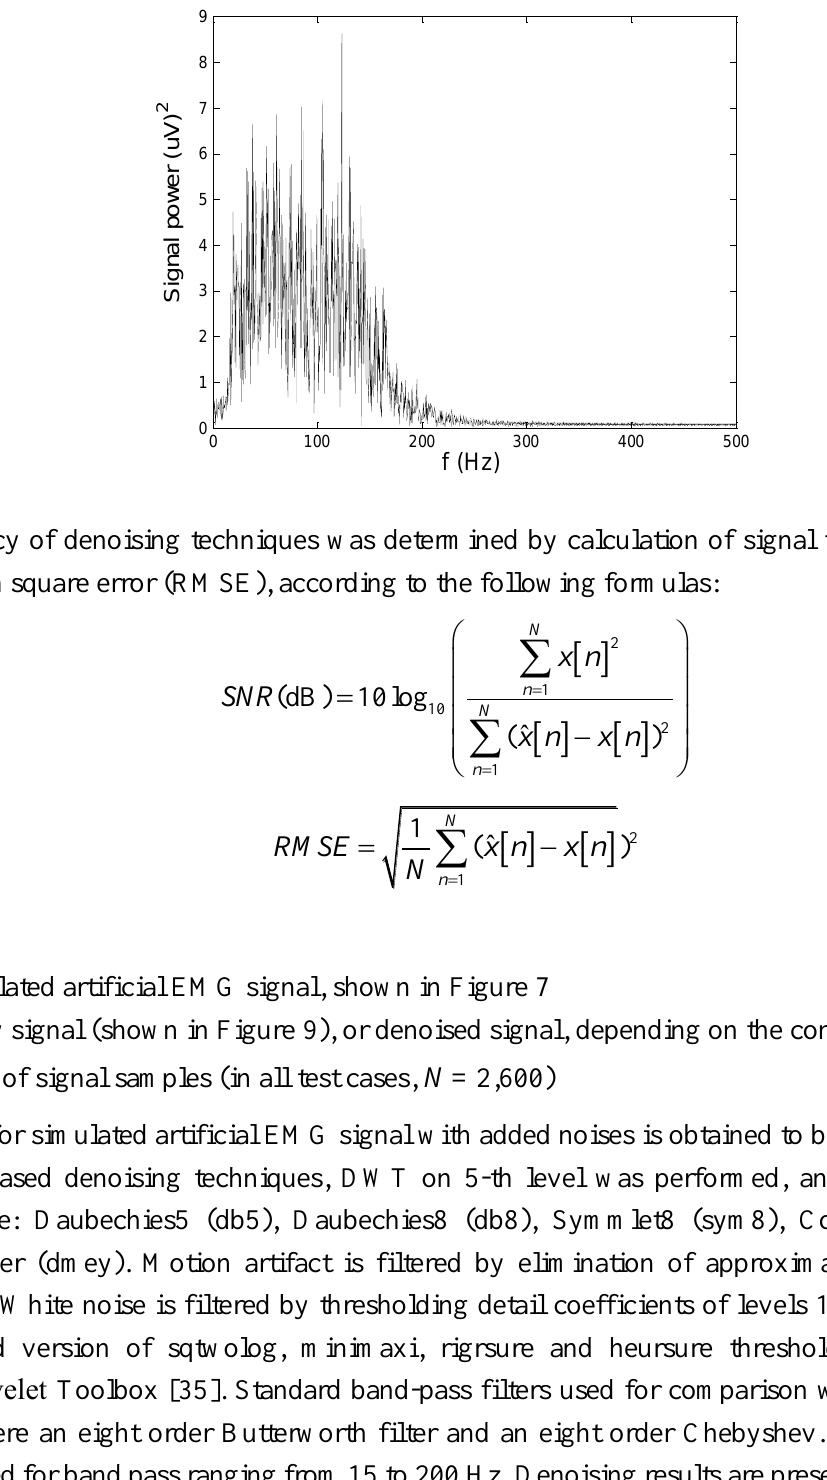
Figure 8. Power spectrum of simulated artificial EMG